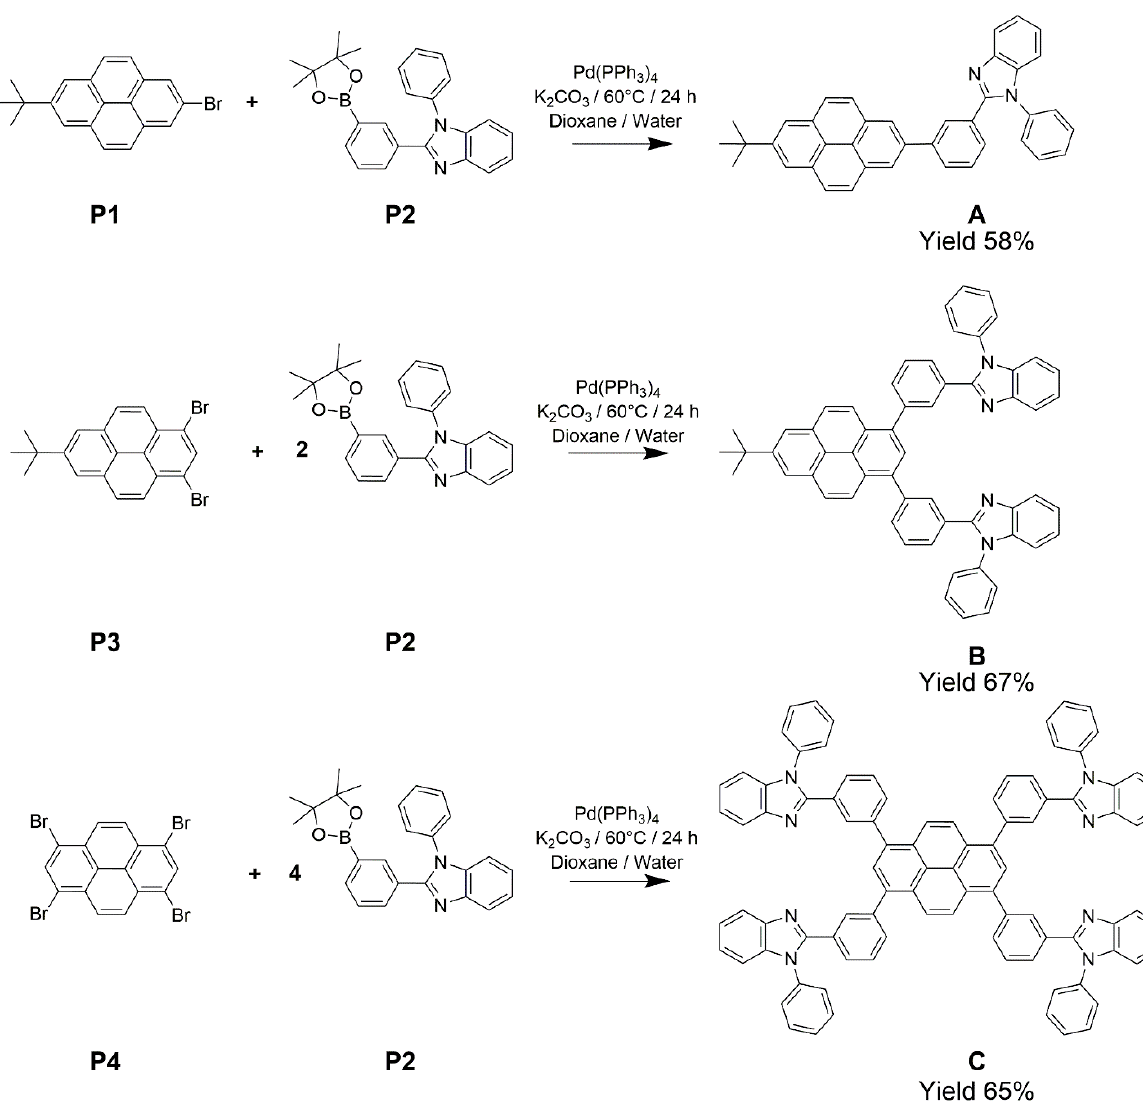
Figure 1. Synthesis and structure of pyrene-benzimidazole derivatives, 2-(1,2-diphenyl)-1 H -benzimidazole-7- tert -butylpyrene (compound A ), 1,3-di(1,2-diphenyl)-1 H -benzimidazole-7- tert -butylpyrene (compound B ), and 1,3,6,8-tetra(1,2-diphenyl)-1 H -benzimidazolepyrene (compound C ).